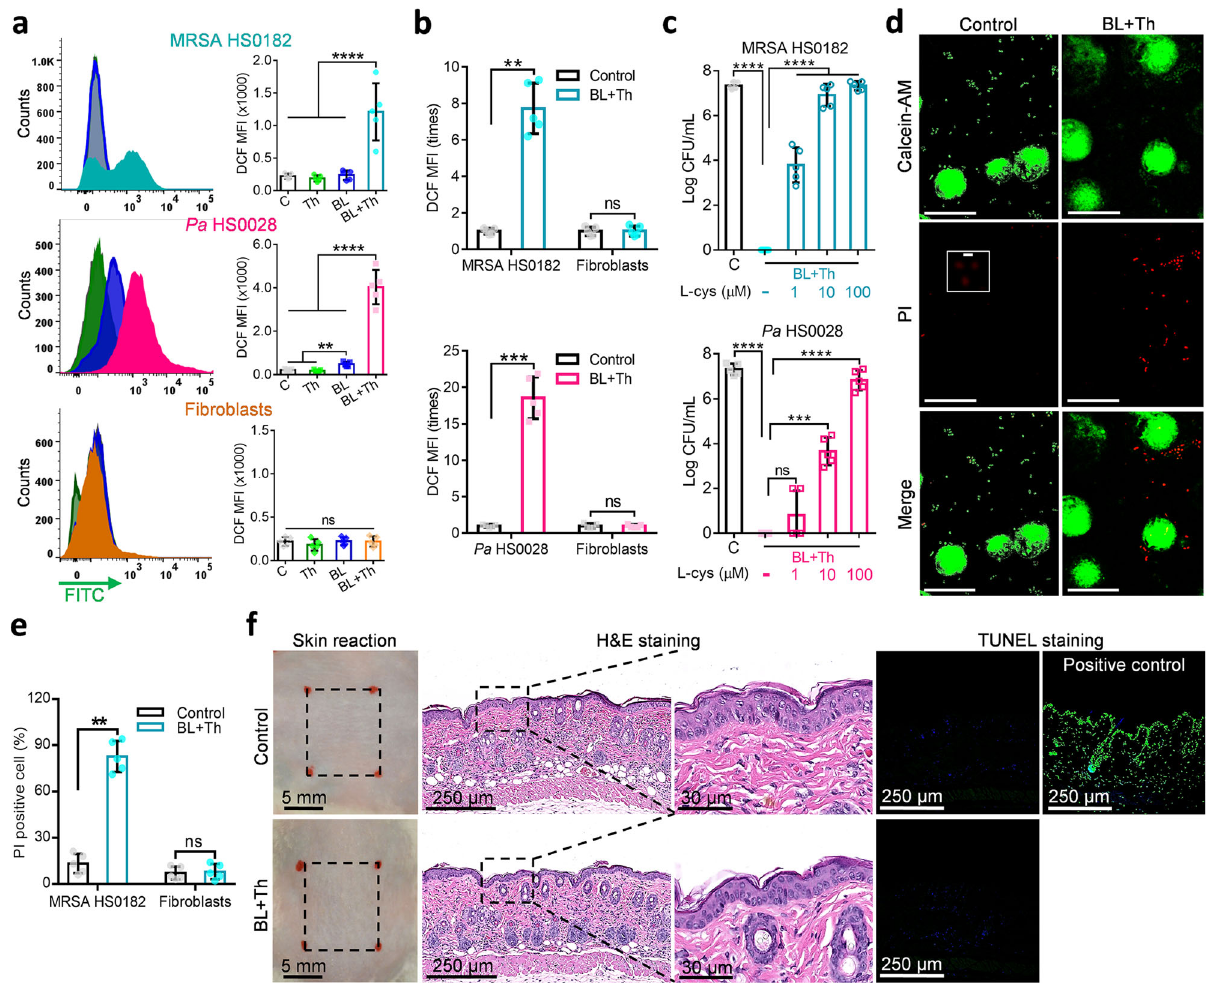
Fig. 5 No adverse effects of BL combined with thymol treatment on fi broblast and murine skin. a Flow cytometric analyses of intracellular ROS in MRSA HS0182 (upper), Pa HS0028 (medium), and fi broblasts (bottom) treated with sham light (C), thymol at 1/2 MIC (Th), an indicated BL fl uence (BL), or both (BL + Th) by DCFH-DA fl uorescent staining. MRSA HS0182 was exposed to thymol at 0.15 mg/mL, BL at 50 J/cm 2 , or both, and Pa HS0028 to thymol at 0.3 mg/mL, BL at 25 J/cm 2 , or both. Alternatively, fi broblasts alone ( a , bottom) or the cells co-cultured with MRSA HS0182 ( b , upper) or Pa HS0028 ( c , bottom) were treated with thymol at 0.5 mg/mL, BL at 50 J/cm 2 , or both. DCF mean fl orescence intensity (MFI) on gate of bacteria or fi broblasts was presented in a and fold changes of DCF MFI relative to sham-treated controls were shown in b . c Dose-dependent effects of antioxidant L-cys on the bactericidal activity of the combined therapy: 50 J/cm 2 BL and 0.15 mg/mL thymol for MRSA HS0182 and 25 J/cm 2 BL and 0.3 mg/mL thymol for Pa HS0028. d Representative fl uorescence images of co-culture of MRSA HS0182 and fi broblasts were shown, in which the dead and viable cells were visualized by PI (red) and calcein-AM staining (green), respectively. Scale bars, 20 µ m. An area in the middle panel (control PI) was enlarged to show a few PI-stained bacteria (Scale bars, 2 µ m). e PI + MRSA HS0182 and PI + fi broblasts in co-cultures were also counted manually and presented as percentages relative to a total of cells. f No adverse effect of topical application of BL and thymol in murine skin. The dorsal skin was topically treated with sham (control) or 100 J/cm 2 BL and 50 µ L of thymol at 20 mg/mL (BL + Th) once a day for 5 consecutive days. On day 6, the skins were processed by H&E histological examination and TUNEL assay. DNase I-treated skins were TUNEL stained in parallel as positive-staining controls. All results are presented as mean ± SD of at least fi ve biological replicates. Images in d and f are representative of fi ve independent experiments. **** P < 0.0001; *** P < 0.001; ** P < 0.01; and ns, no signi fi